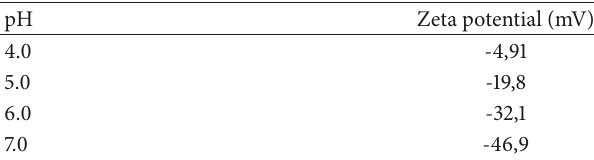
Table 3: Effect of pH on zeta potential